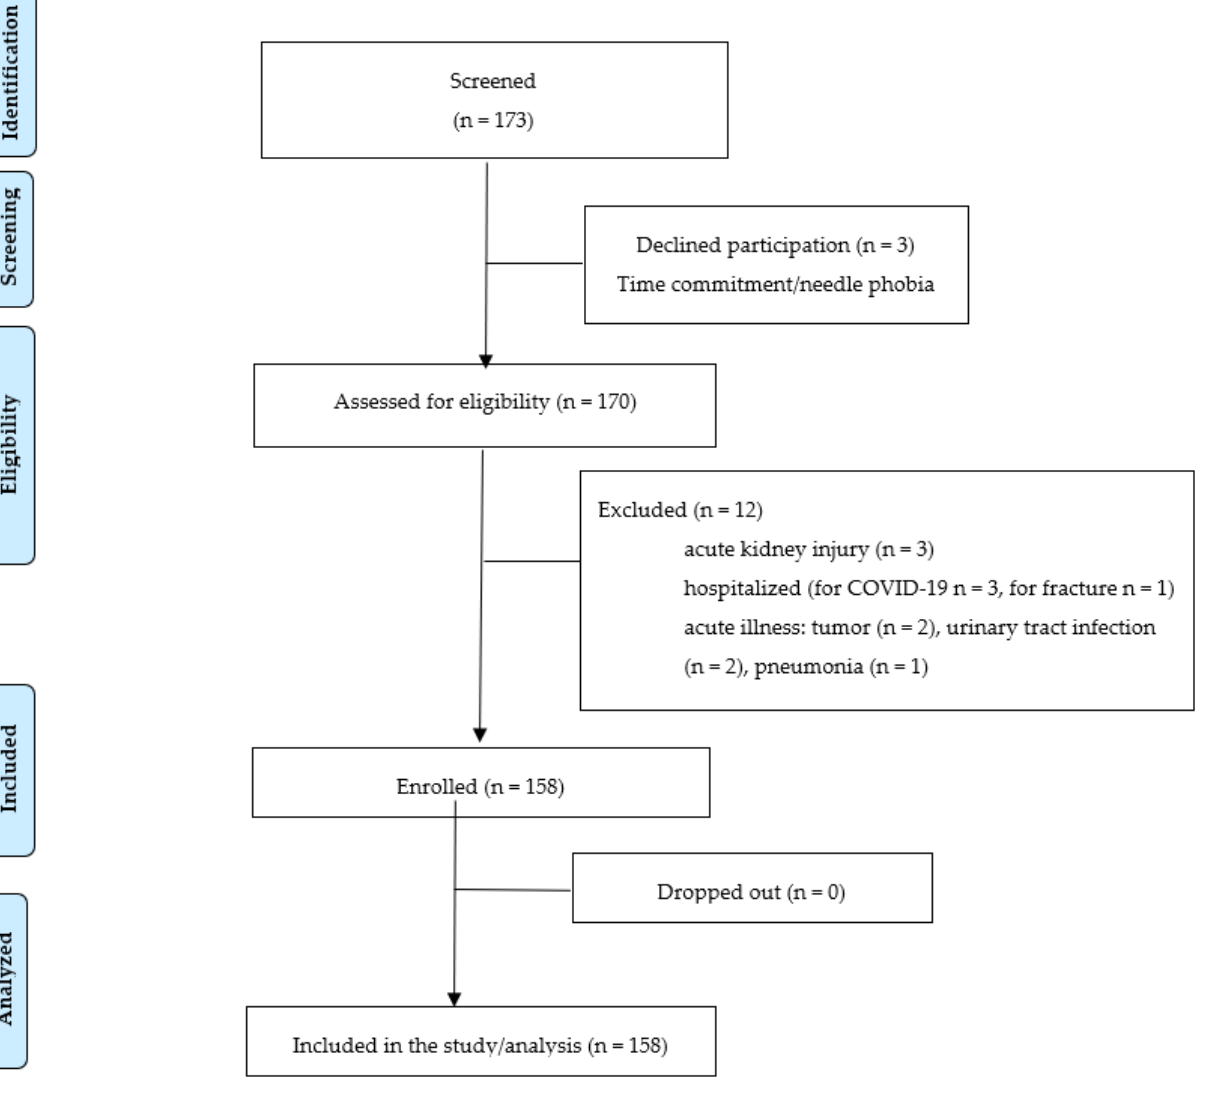
Figure 1. Patients’ enrolment flow chart.